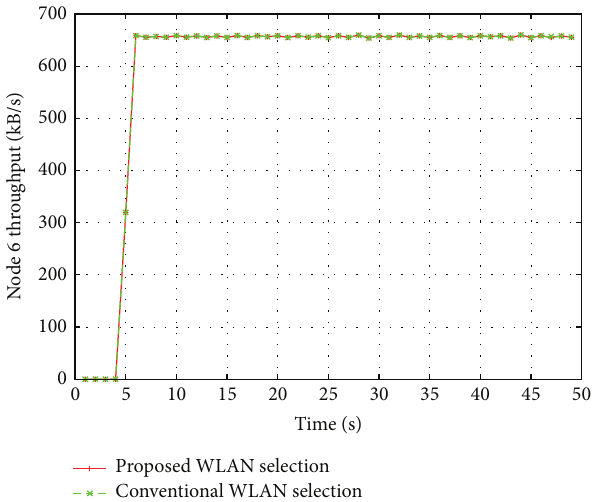
Figure 8: WiFi AP2 (Node 15) throughput.